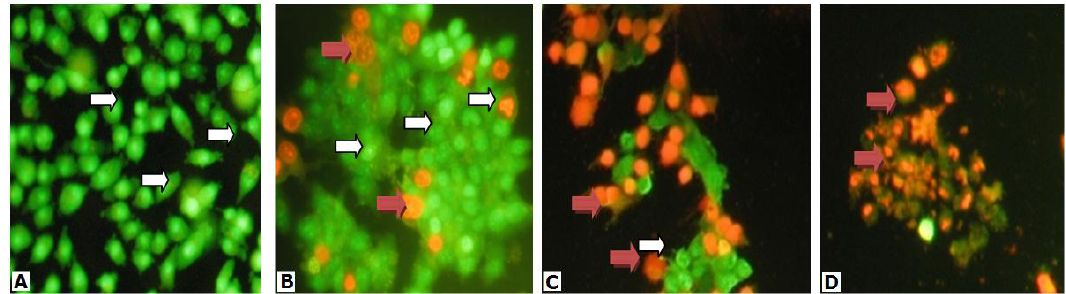
Figure 3. Apoptotic cells observation using double staining method under flourencence microscope using 400x magnification. (A)Untreated cells, (B)Cells treated 17µg/mL MPE (Cpoint C: MPE concentration should be "cells treated 34ug/mL MPE" (as described on the text) not 'cells treated 13ug/mL'; (D) Cells treated 12,65.10 -7 µg/mL tamoxifen living cells; apoptotic cells.